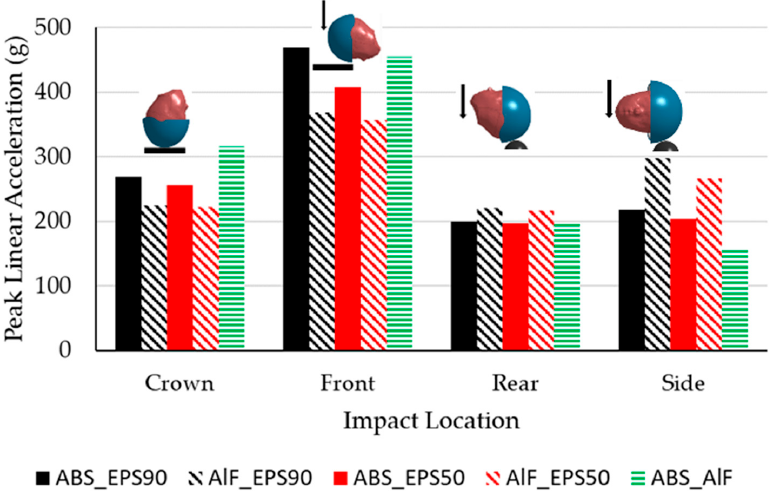
Figure 11. Comparisons of the peak linear acceleration obtained from the DOT drop test for five combinations of helmet material.